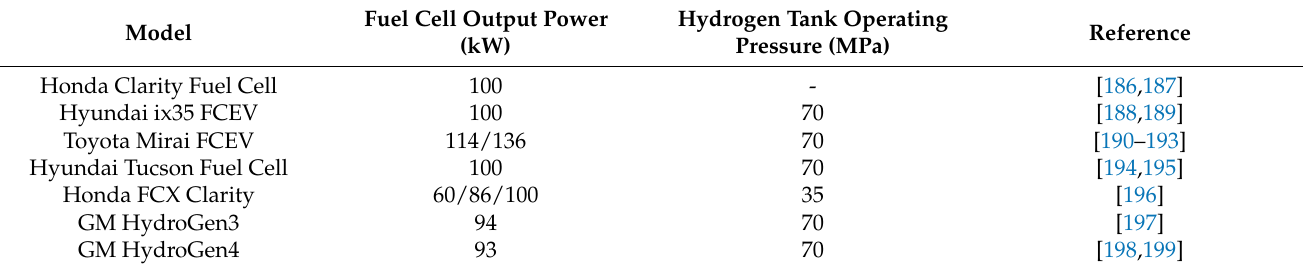
Table 5. Hydrogen fuel cell electric